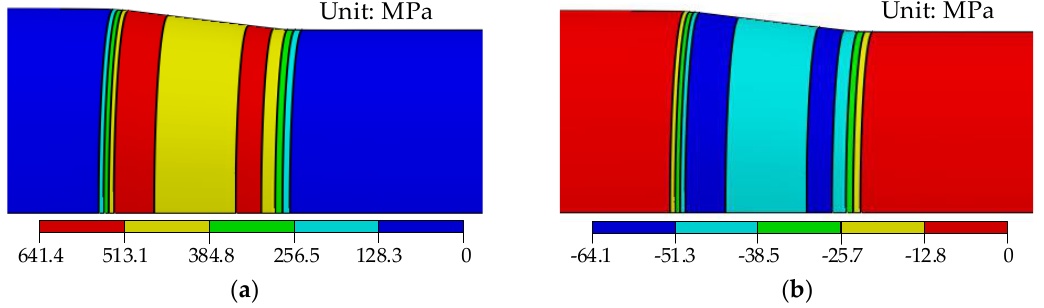
Figure 15. Contact stress and friction stress distribution at the contact interface under conventional drawing conditions: ( a ) Contact stress distribution; ( b ) Friction stress distribution.